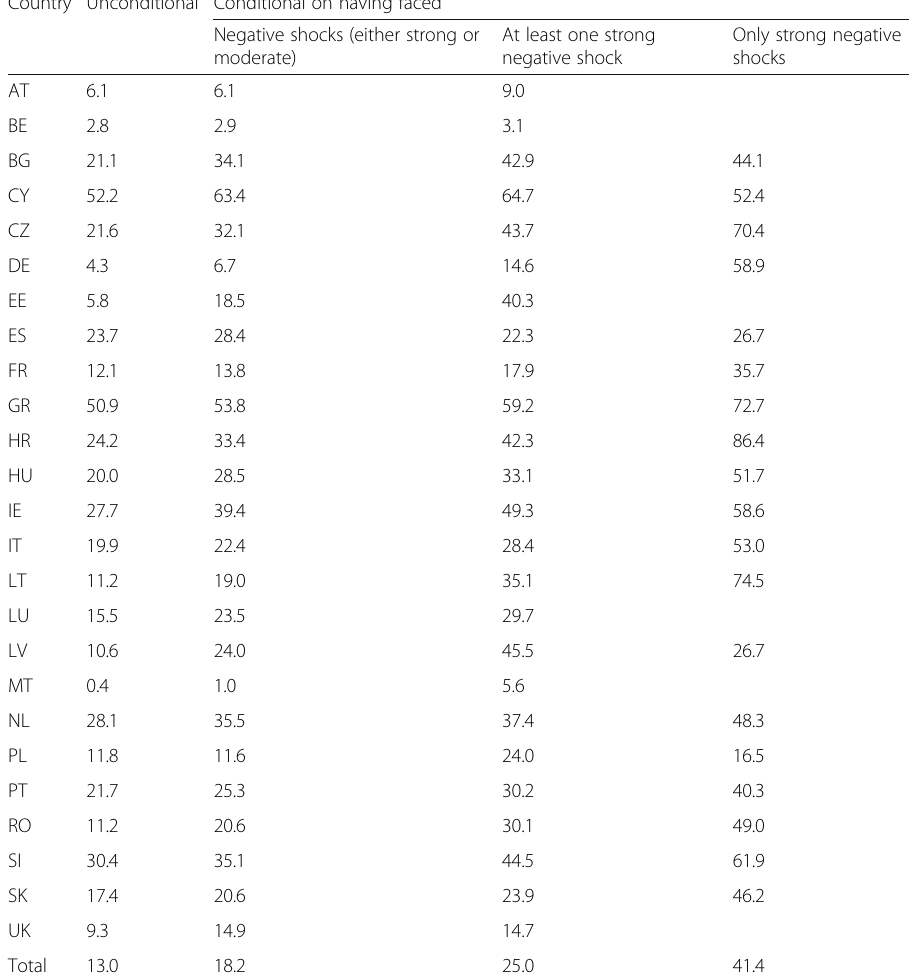
At least one strong Only strong negative negative shock shocks